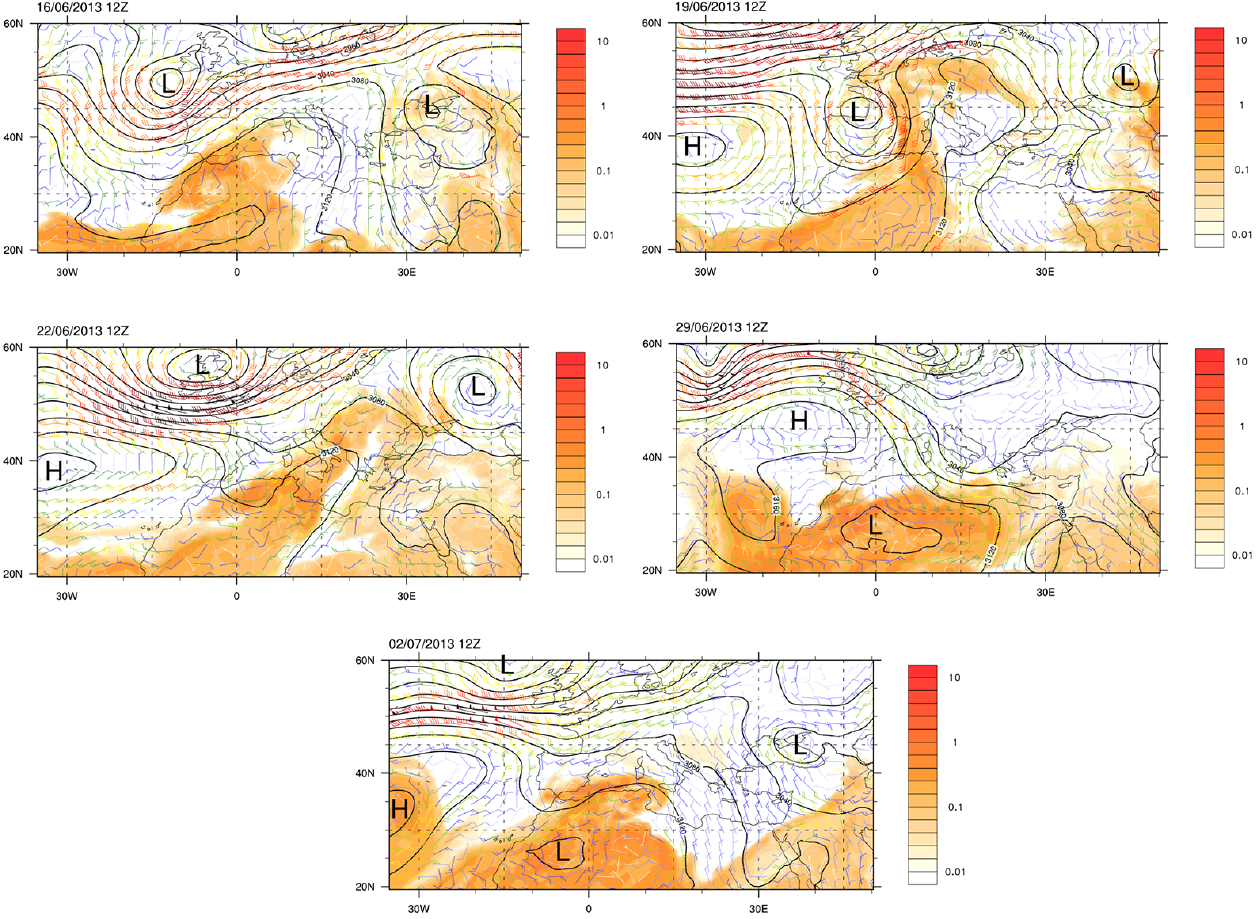
Figure 7. Geopotential and wind intensity at 700hPa (ERA-Interim reanalysis), and mass dust concentration (in mgm − 3 ) simulated from the ALADIN-Dust model for 6, 19, 22, 29 June and 2 July at